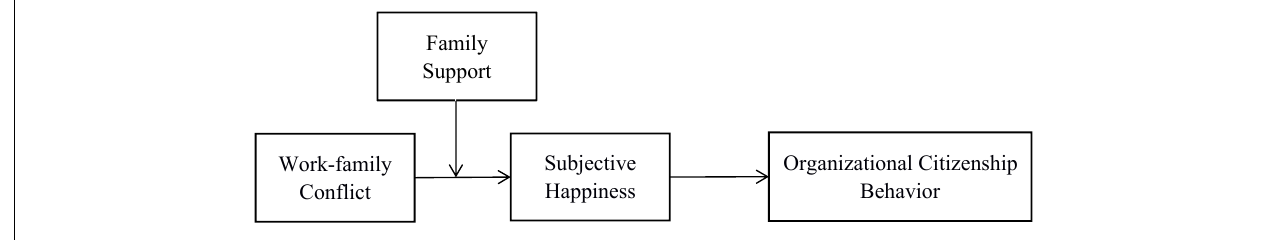
FIGURE 1 | Hypothesized model of processes linking work-family conflict and organizational citizenship